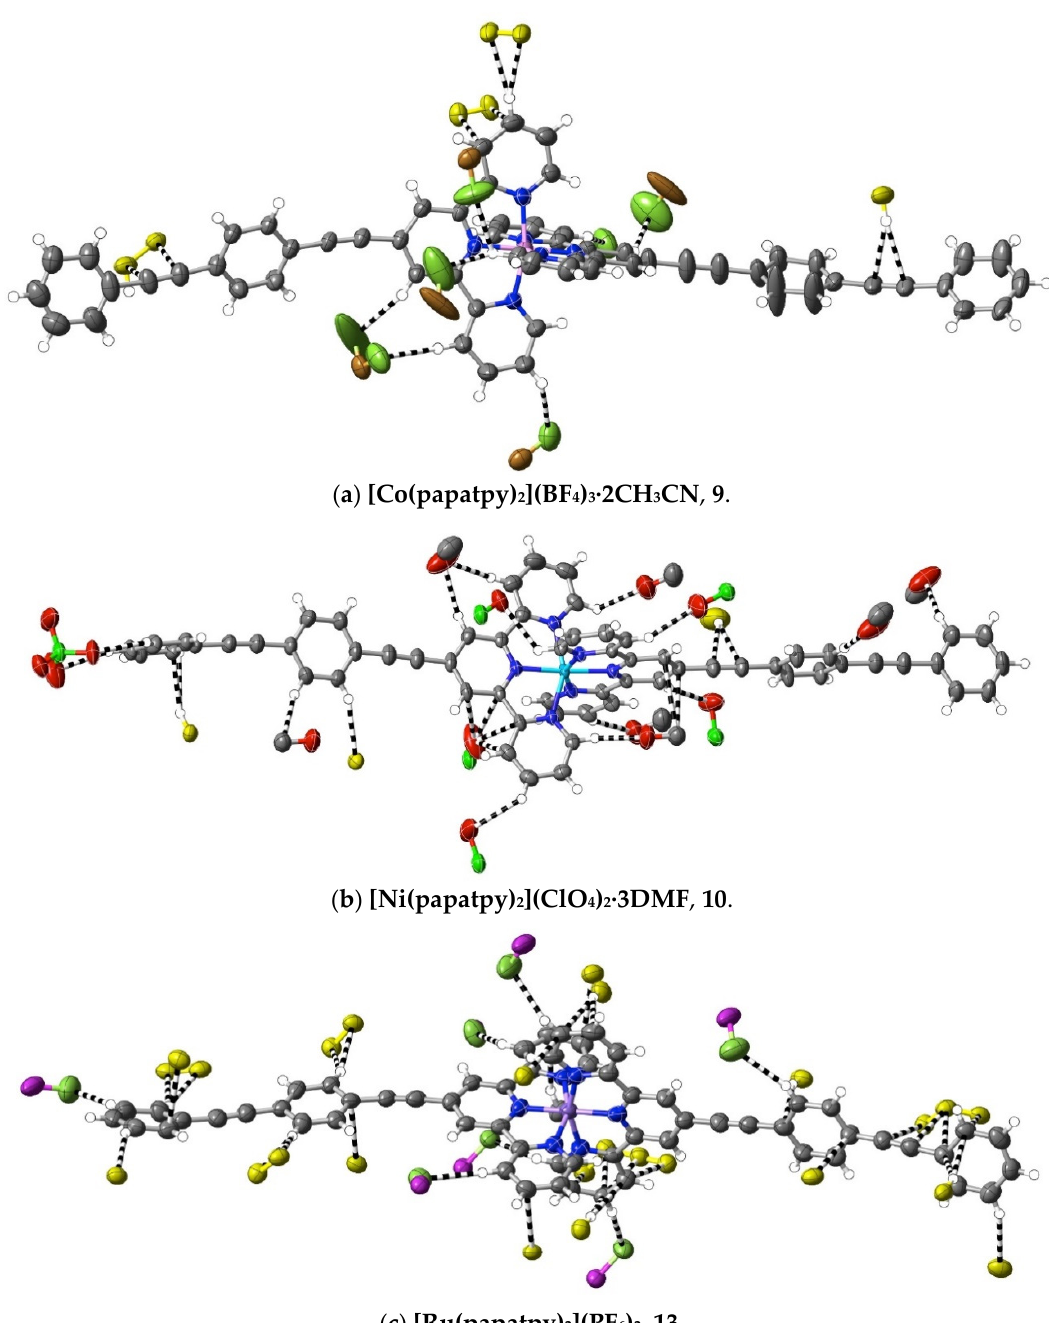
Figure 5. Interactions beyond dispersion involving the ethynyl subunits in complexes of phenylethynyl derivatives of 2,2 ′ :6 ′ ,2 ″ -terpyridine. Colour coding as in Figure 1.